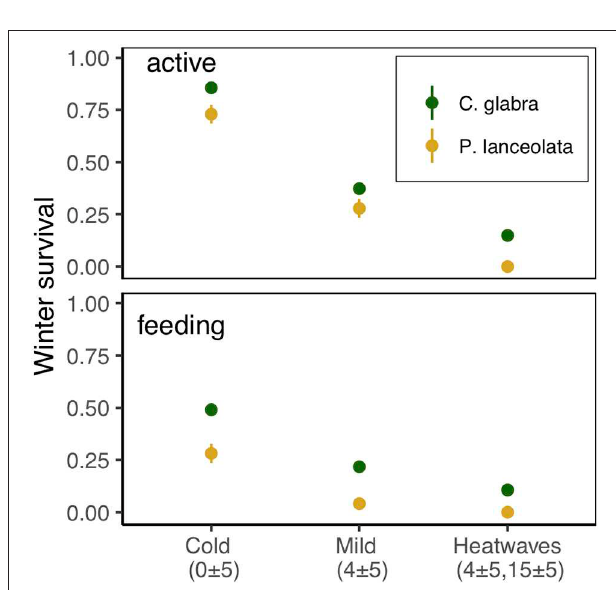
FIGURE 7 | Survival of dormant E. phaeton larvae exposed to cold, mild, or heatwave winter regimes at two different times, March 19th, 2018 (active) and March 28th, 2018 (feeding).